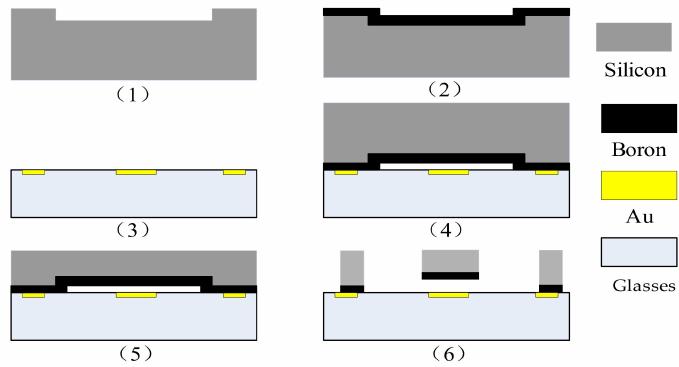
Figure 3. Bulk silicon technological process. (1) clean the monocrystalline silicon wafer and etch the bonding platform; (2) dope with concentrated boron via a diffusion process;(3) sputter Au on the borosil-icate glass; (4) bond the glass and silicon through the anode; (5) dry-etched with excess silicon; (6) etch the back of the silicon wafer.